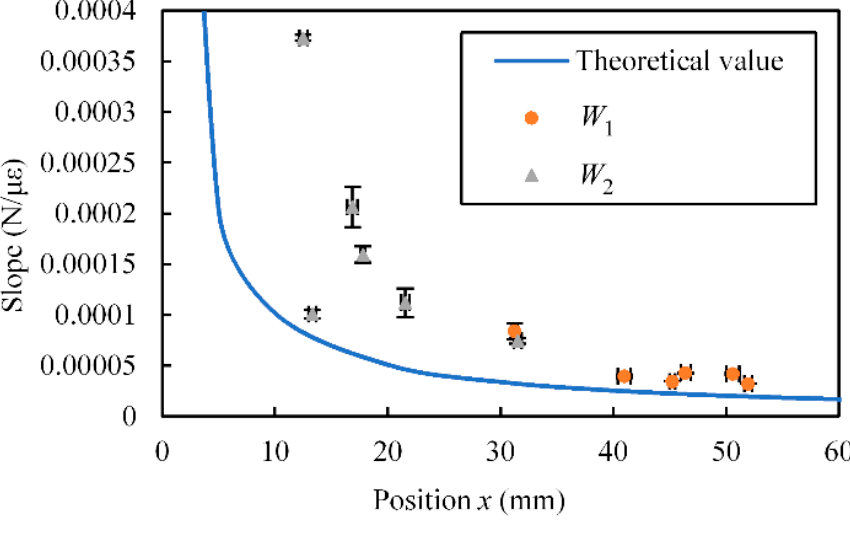
Figure 13. Relationship between x and slope for SMP FS.